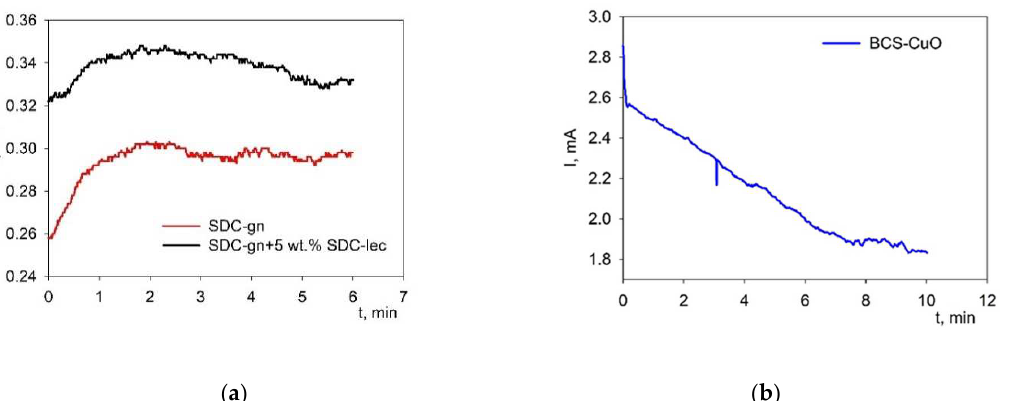
Figure 2. Change in the current strength with time during EPD on the Ni-foil model electrode: ( a ) for the suspensions of 10 g/L SDC-gn/lec and 10 g/L SDC-gn (V = 60 V, t = 6 min); ( b ) for the suspension of 10 g/L BCS-CuO (V = 80 V, t = 10 min).